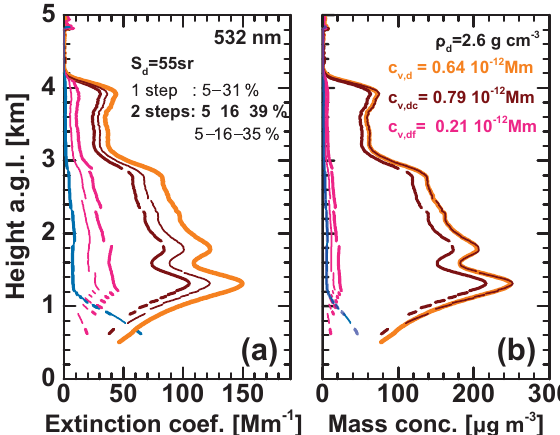
Figure 12. Comparison of the Raman-lidar-derived particle extinc- tion coefficient at 532nm (in green) and the POLIPHON extinction coefficient (in blue and black). In the case of the blue POLIPHON profile (for the mixture of dust and marine aerosol) the non-dust backscatter coefficient (in Fig. 10d) is multiplied with a marine li- dar ratio of 20sr and added to the dust backscatter contributions multiplied by a lidar ratio of 55sr. The black curve (for the mix- ture of dust and anthropogenic aerosol) is obtained when the non- dust backscatter component is multiplied with a typical haze and smoke lidar ratio of 50sr at 532nm. To reduce the uncertainty by signal noise, signal smoothing with window lengths of 300m (up to 2.4km height), 500m (up to 3km), and 750m (above 3km) was applied in the Raman lidar data analysis. Uncertainties are on the order of 10% (Raman lidar profile, green error bars) and 20% in the case of the POLIPHON